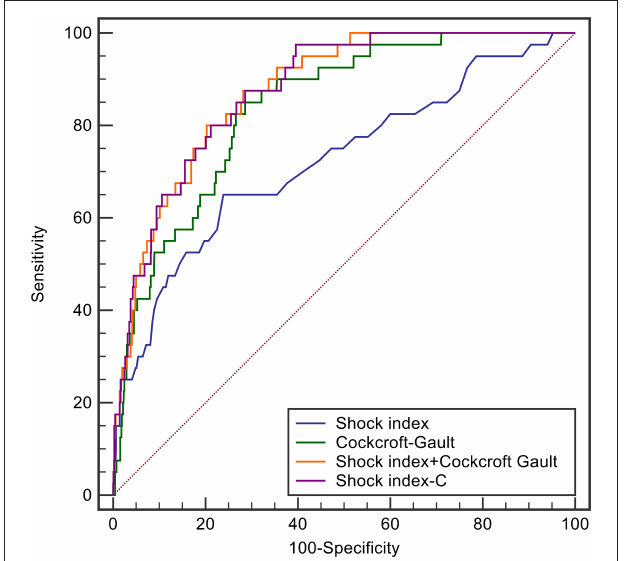
FIGURE 3 | Decision curve analysis of shock index-C and shock index for in-hospital death in the derivation database. TABLE 3 | Subgroup